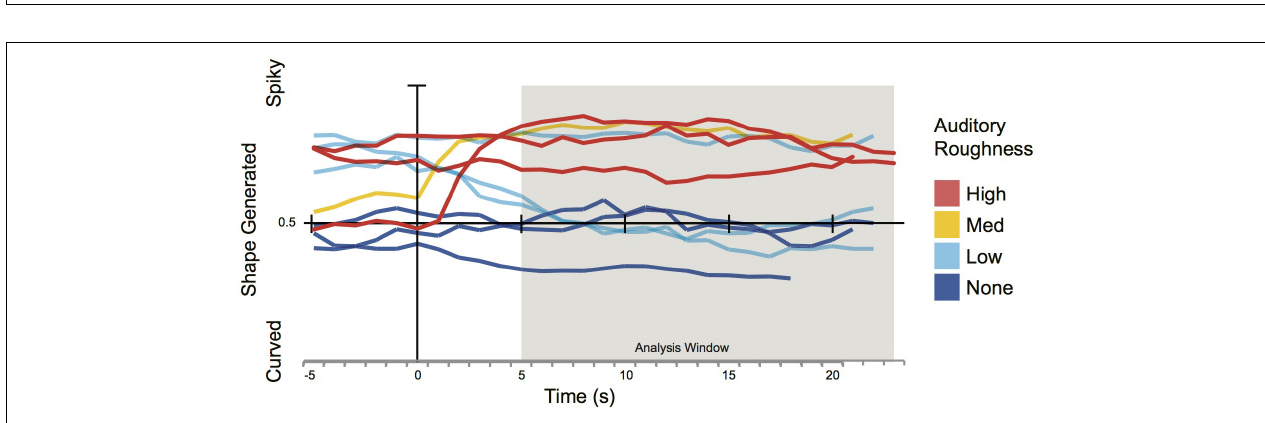
FIGURE 5 | A time-series visualisation of aggregated participant (audience) responses between Experiments 1 (Live Concert Audience) and 2 (Individual Laboratory Playback). Thick line indicates group mean. Thin lines indicate individual responses (Experiment 2 only). Note that the coding of time stamps in Experiment 1 suffered from a slight lag meaning that each ‘second’ was actually slightly larger than 1 s. Scales have been equated for visual comparison.